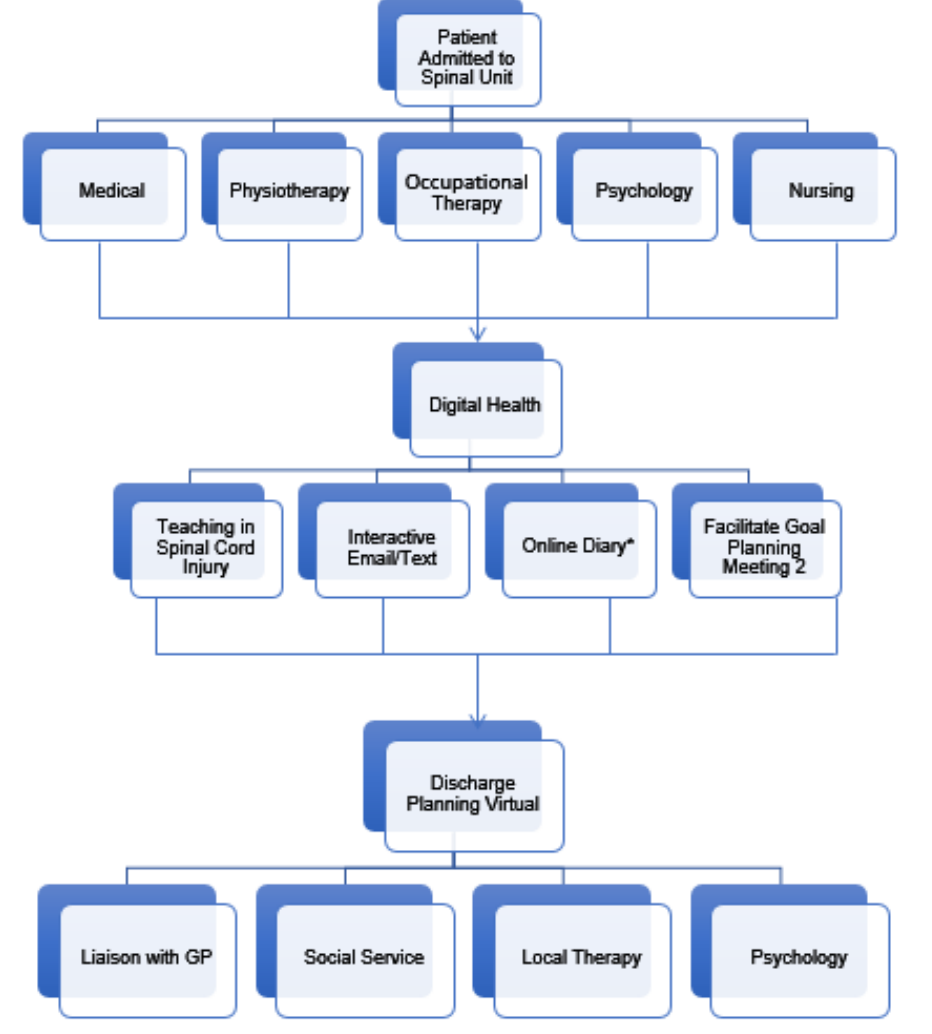
Figure 5: Use of technology in acute